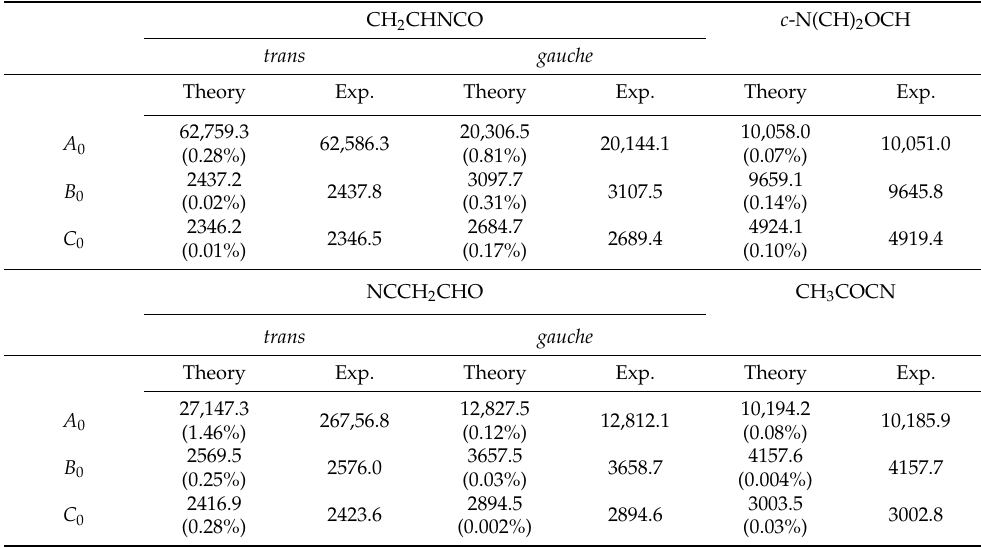
Table 1. Experimental a (Exp.) and computed b (Theory) rotational constants of the vibrational ground state (MHz) for vinylisocyanate ( t and g ), oxazole, cyanoacetaldehyde ( t and g ) and pyruvonitrile.